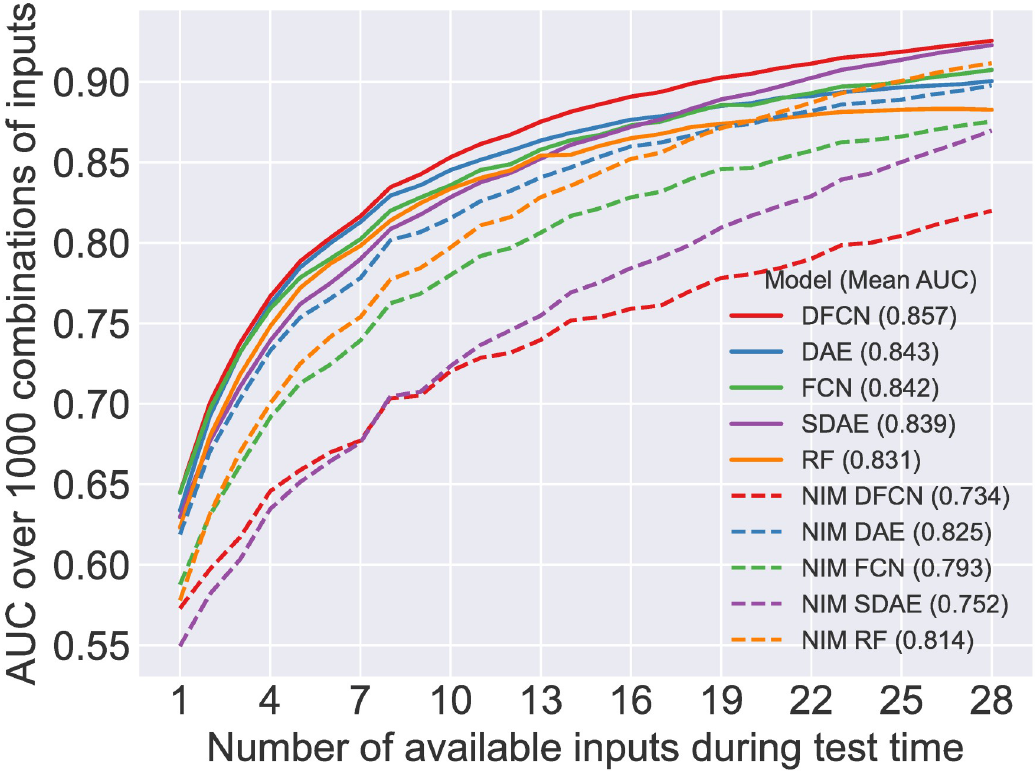
Fig 5. Comparison of the 10 selected models on test datasets with an increasing number of available inputs. Each test dataset is composed of 1000 random combinations of n inputs (n from 1–28) as described in experiment Ablation study on independent test dataset. Models are trained without input masking (NIM), or with the optimal input masking as per Table 2. Mean AUC across all numbers of available inputs (1–28) is provided in the